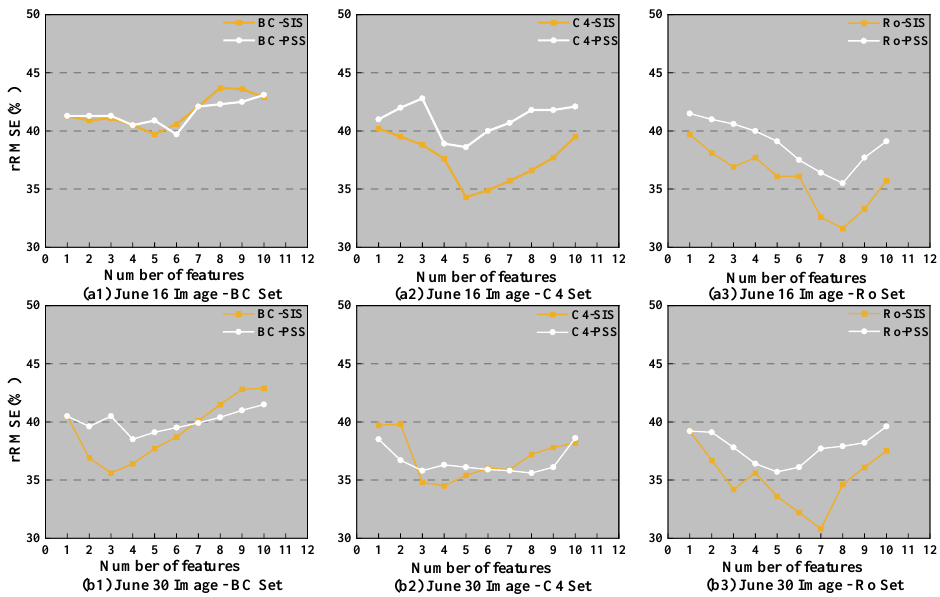
Figure 9. Plots of rRMSE varied with the number of features with two feature selection methods.